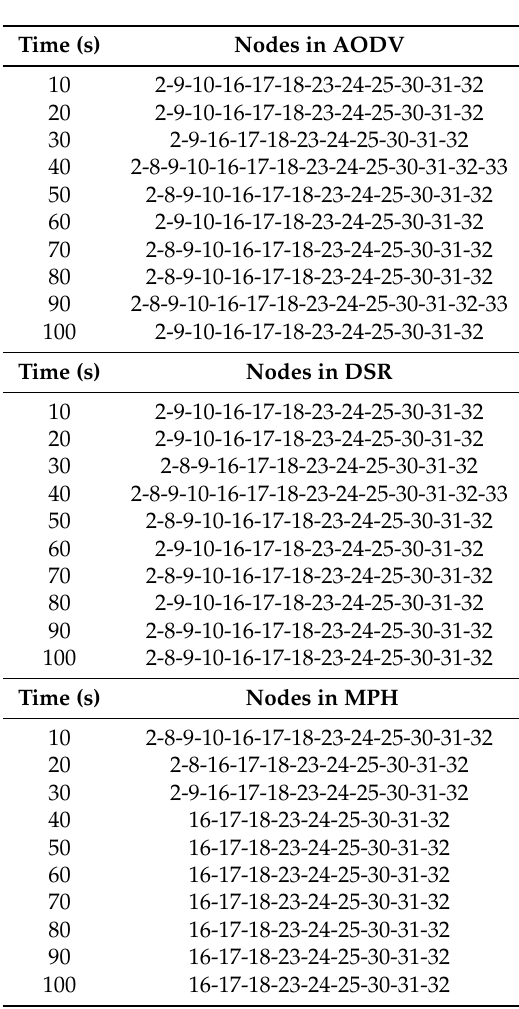
Table 2. Nodes with positive detection of